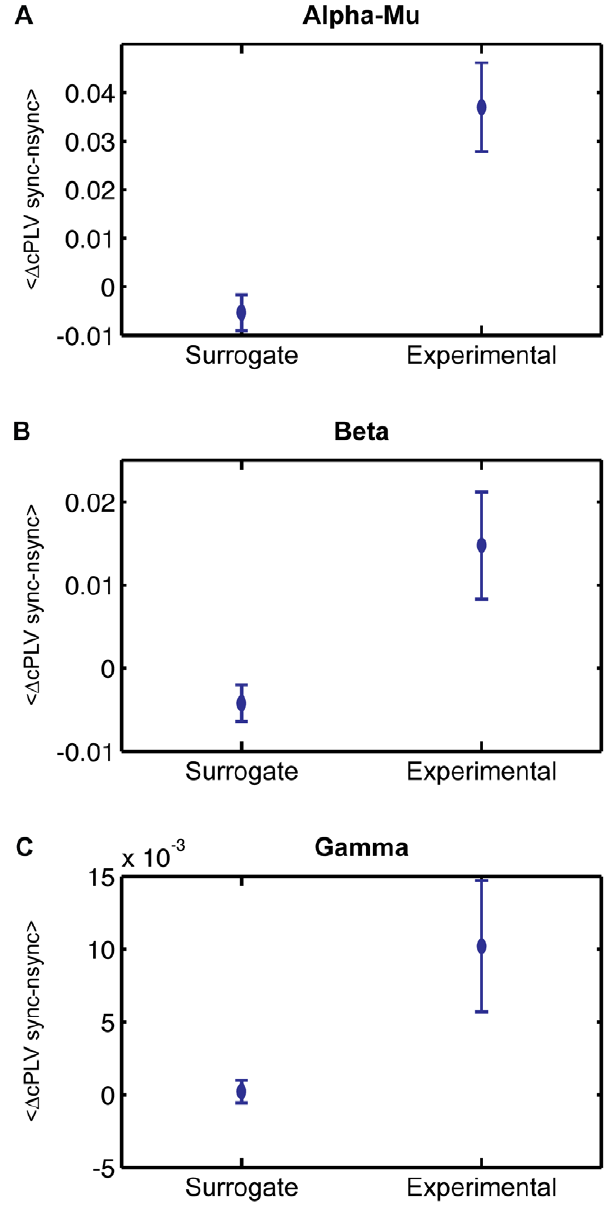
Figure 5. Averaged intersubject clustered PLV (cPLV) differ- ence between synchronous and non-synchronous interactions (Sync - NSync) compared for experimental and surrogate behavioral analysis. Bars represent standard errors.